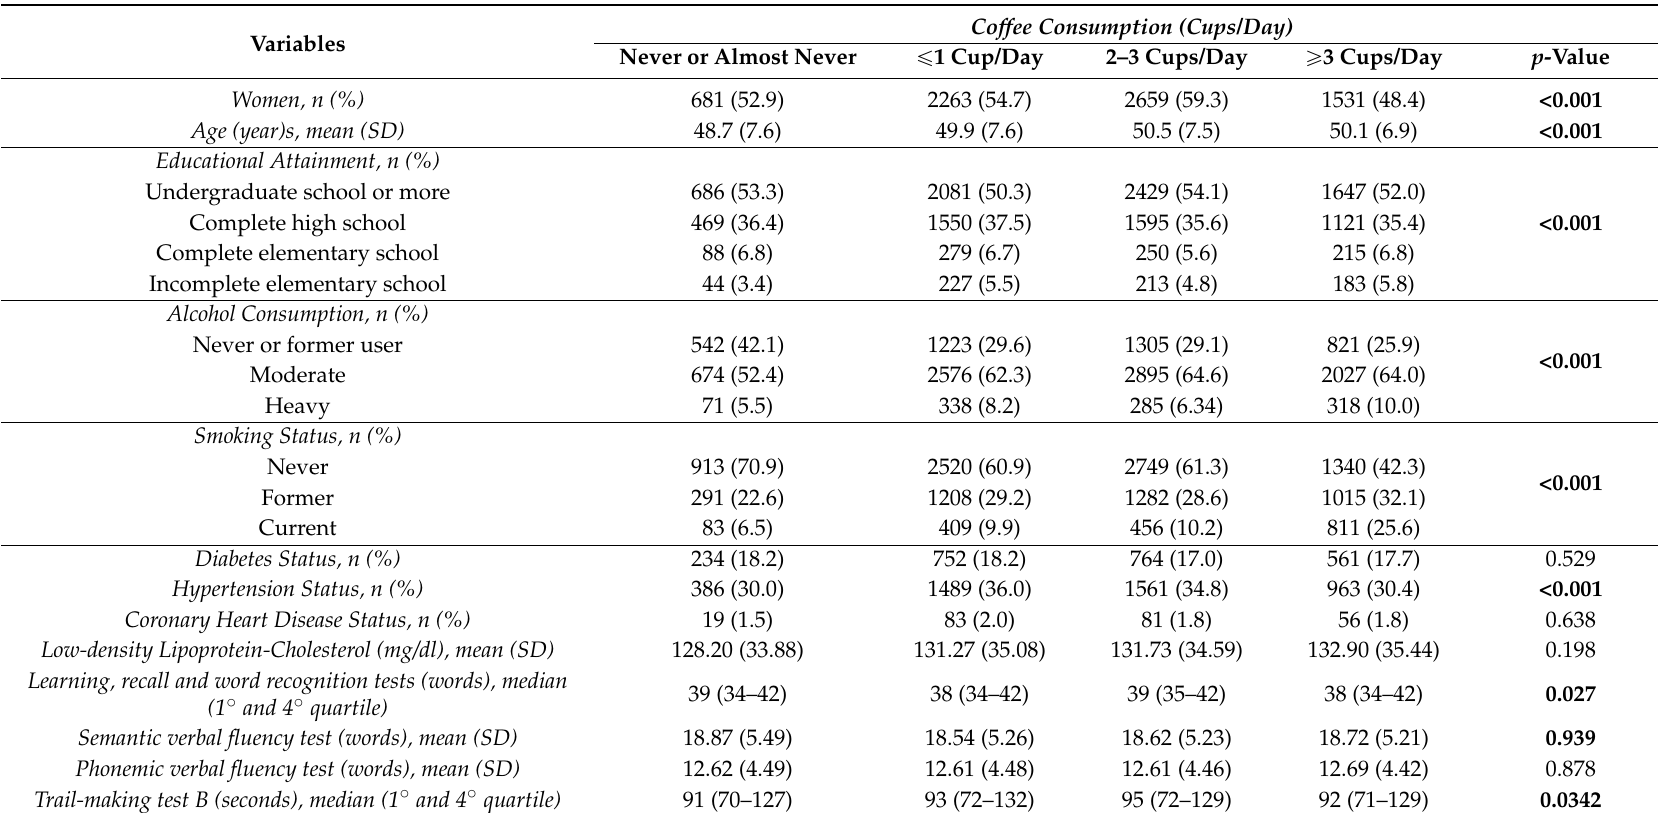
Table 1. Characteristics of the study population (35–64 years old) of ELSA-Brasil